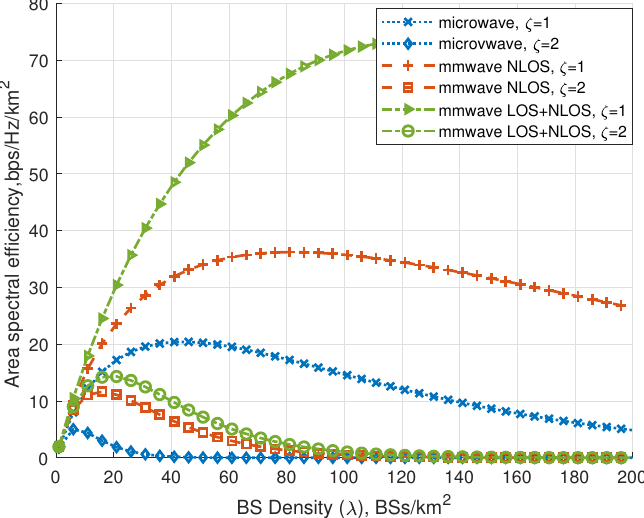
Figure 7. Impact of BS density ( λ ) on area spectral